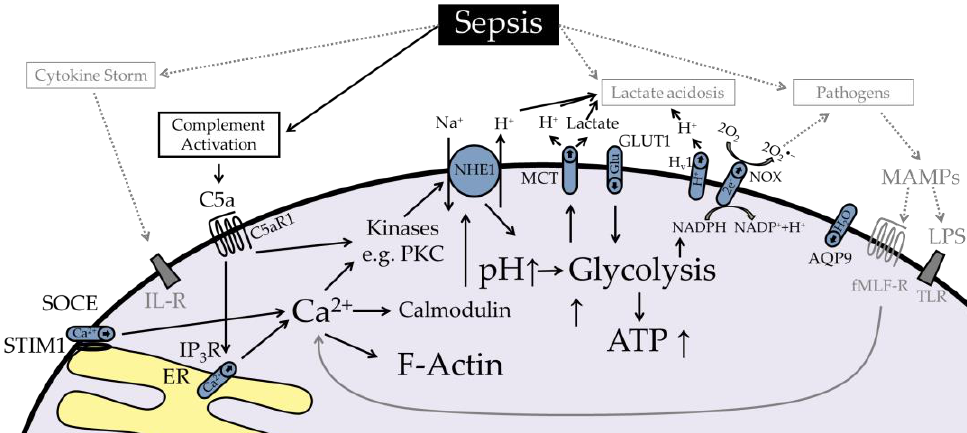
Figure 1. Simplified summary of the response of neutrophils upon stimulation with chemoattracttants with a focus on the well-studied C5a-C5aR1 axis. The anaphylatoxin C5a induces an increase in intracellular Ca 2+ , depolarization, and changes in cellular pH and size. fMLF induces similar signaling. AQP9-regulation has hitherto only been demonstrated for fMLF. SOCE = store-operated calcium entry, STIM1 = stromal interaction molecule 1, ER = endoplasmic reticulum, IP 3 R = inositol 1,4,5-trisphosphate receptor, IL-R = interleukin receptor, C5a = complement factor 5a, C5aR1 = C5a receptor 1, AQP9 = aquaporin 9, CaM = calmodulin, PKC = protein kinase C, NHE1 = sodium-proton exchanger 1, MCT = monocarboxylate transporter, Glu = glucose, GLUT1 = glucose transporter 1, NOX = NADPH oxidase, H v 1 = voltage-sensing domain only protein, MAMP = microbial-associated molecular pattern, fMLF = N -formylmethionyl-leucyl-phenylalanine, fMLF-R = fMLF receptor, TLR = toll-like receptor.